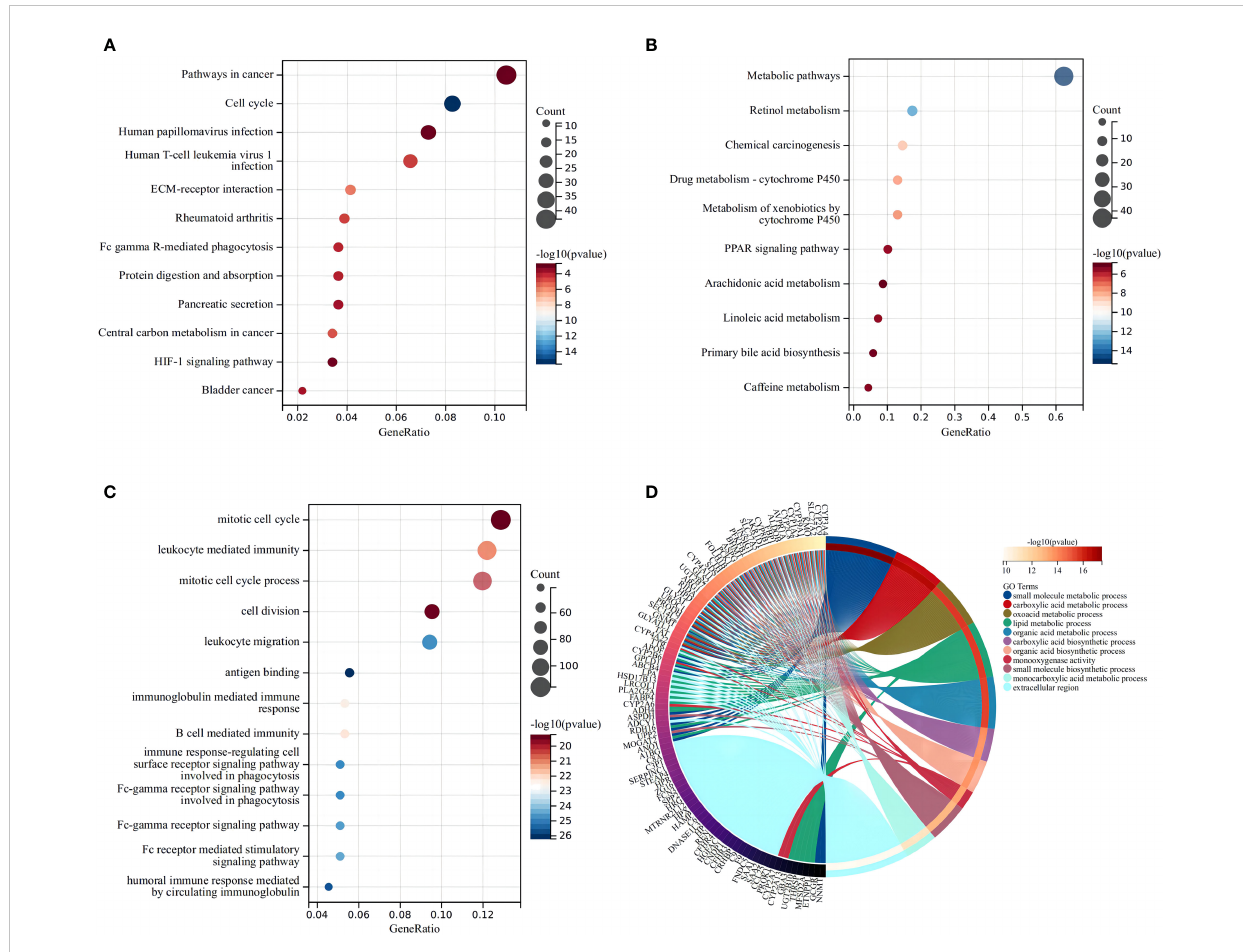
FIGURE 4 Functional analysis based on the differentially expressed genes between the two risk groups in the TCGA cohort. The larger bubble and the longer bar mean that more genes were enriched, and the increasing depth of red means that the differences were more obvious. (A) Bubble graph for the high expression of KEGG pathways in the TCGA cohort. (B) Bubble graph for the low expression of KEGG pathways in the TCGA cohort. (C) Bubble graph for the high expression of GO enrichment in the TCGA cohort. (D) Circular plot for the low expression of GO enrichment in the TCGA